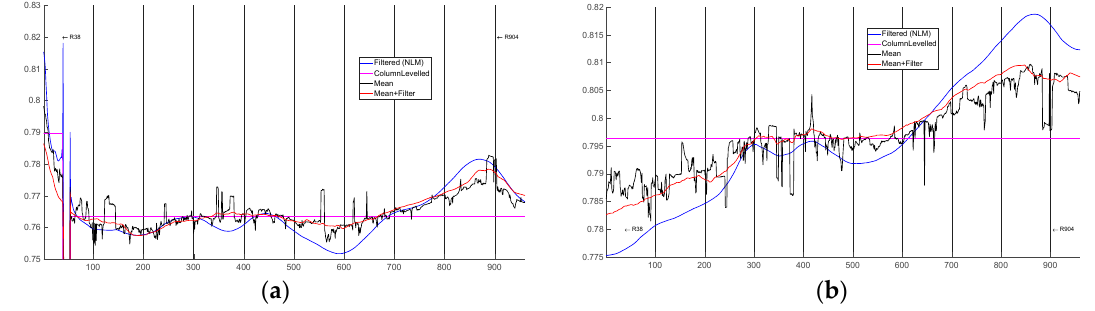
Figure 13. Material drift: ( a ) line segment for C538; ( b ) line segment for C709.